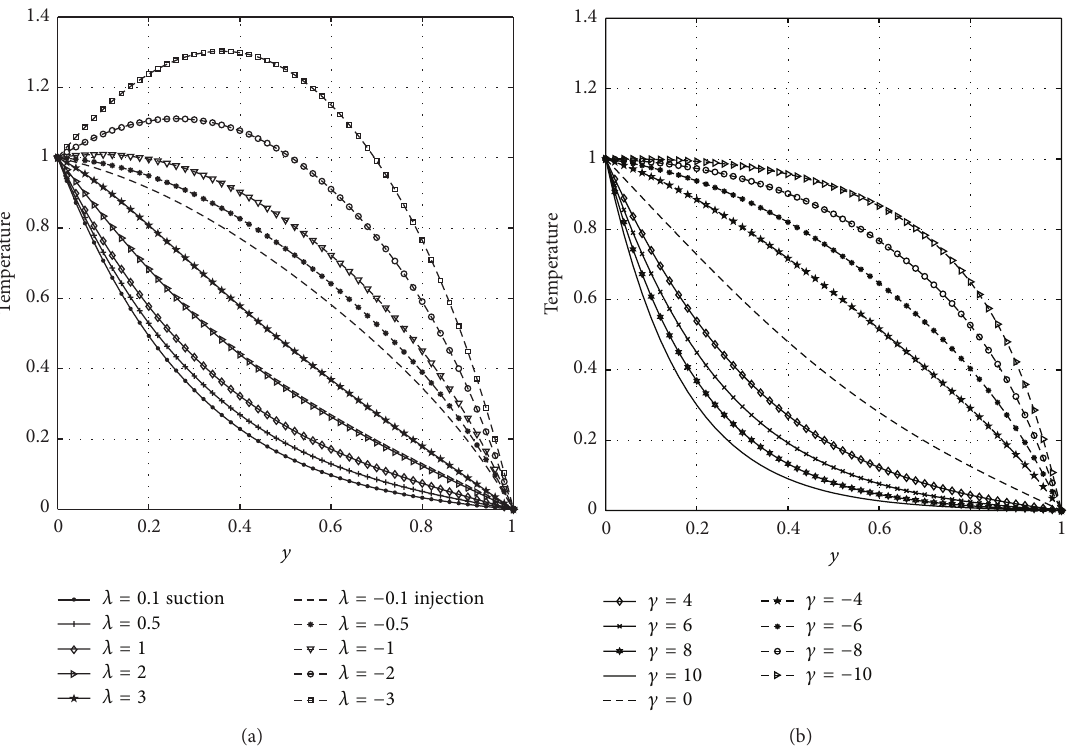
Figure 3: Effects of Frank-Kamenetskii parameter ( 𝜆 ) and suction/injection ( 𝛾 ) on temperature.